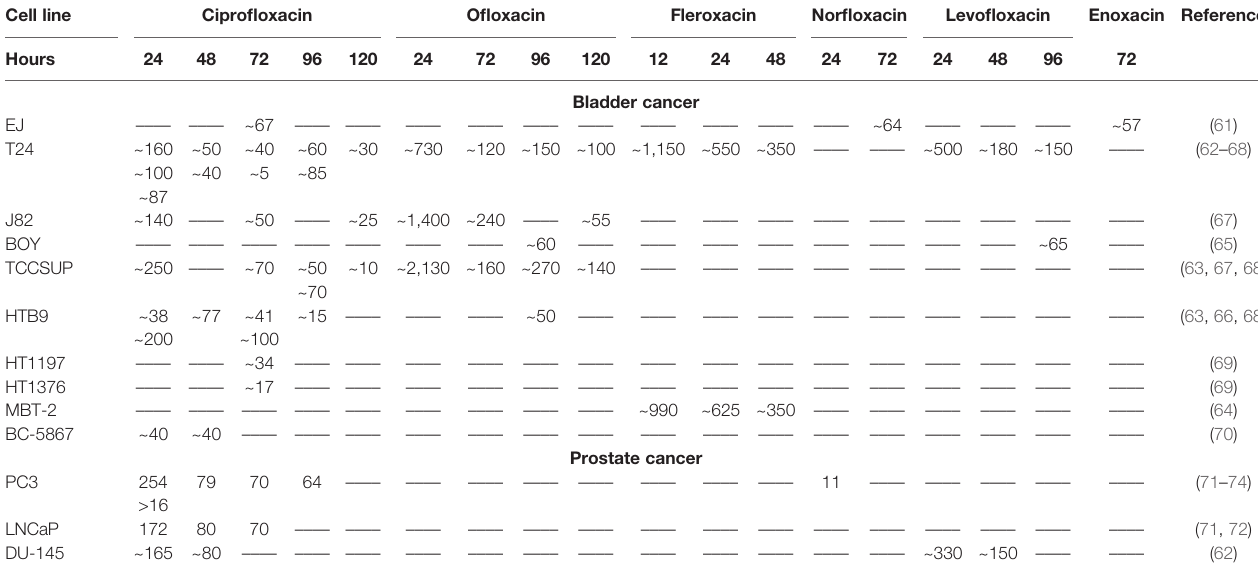
TABLE 3 | IC 50 index ( m g/mL) of individual quinolones for bladder and prostate cancer cell lines depending on incubation time (hours). Cell